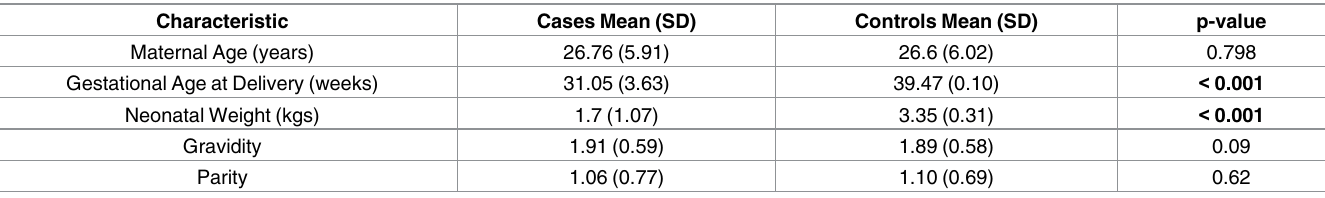
Cases (n = 188) and Controls (n = 175) were compared for key patient characteristics. Values represent means with SDs reported in parentheses for each